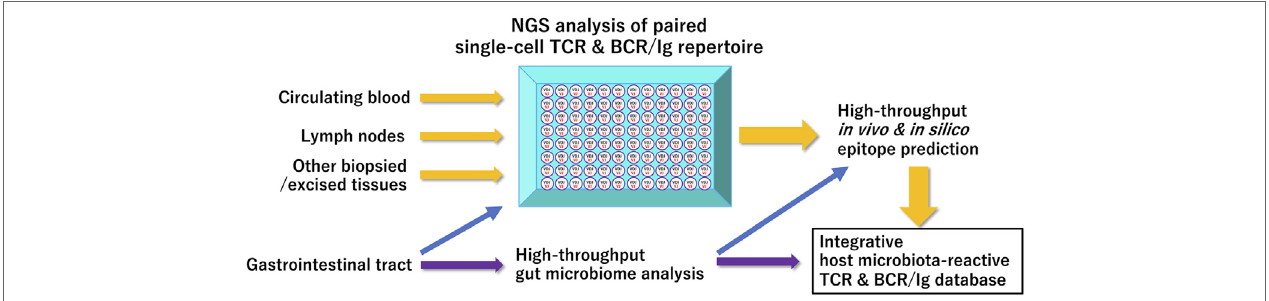
FiGUre 1 | A proposed scheme of integrated bioinformatic analysis of host–microbiome interactions Current high-throughput immune receptor sequencing technologies have facilitated comprehensive paired clonotype determination of acquired immune receptors in a given sample. Integrated accumulation of these paired immune receptor clonotypes in health and diseases with data on gut microbiome of their host origin obtained at appropriate timepoints will enhance our in-depth understanding of shared and unshared features of T- or B-cell receptor repertoire affected by specific gastrointestinal microorganisms. Abbreviations: NGS, next-generation sequencing; TCR, T-cell receptor; BCR/IgG, B-cell